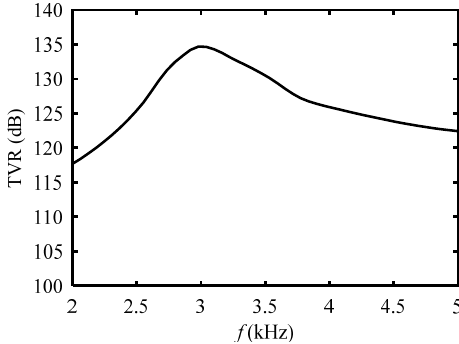
Figure 7. TVR curve of the prototype.